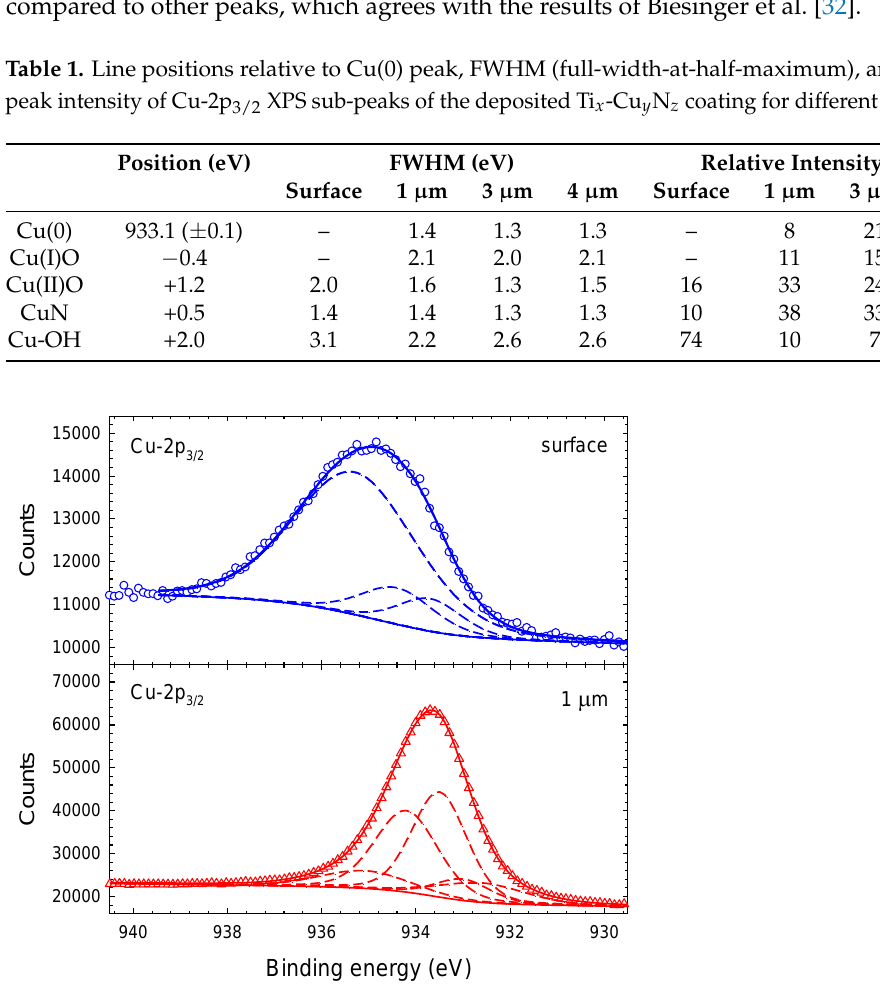
Figure 5. Cu-2p 3/2 peak fitted with 5 sub-peaks (see text) at the surface ( top ) and at a film depth of 1 µ m ( bottom ). Data are fitted with five Lorentzian–Gaussian sub-peaks after subtraction of a Shirley